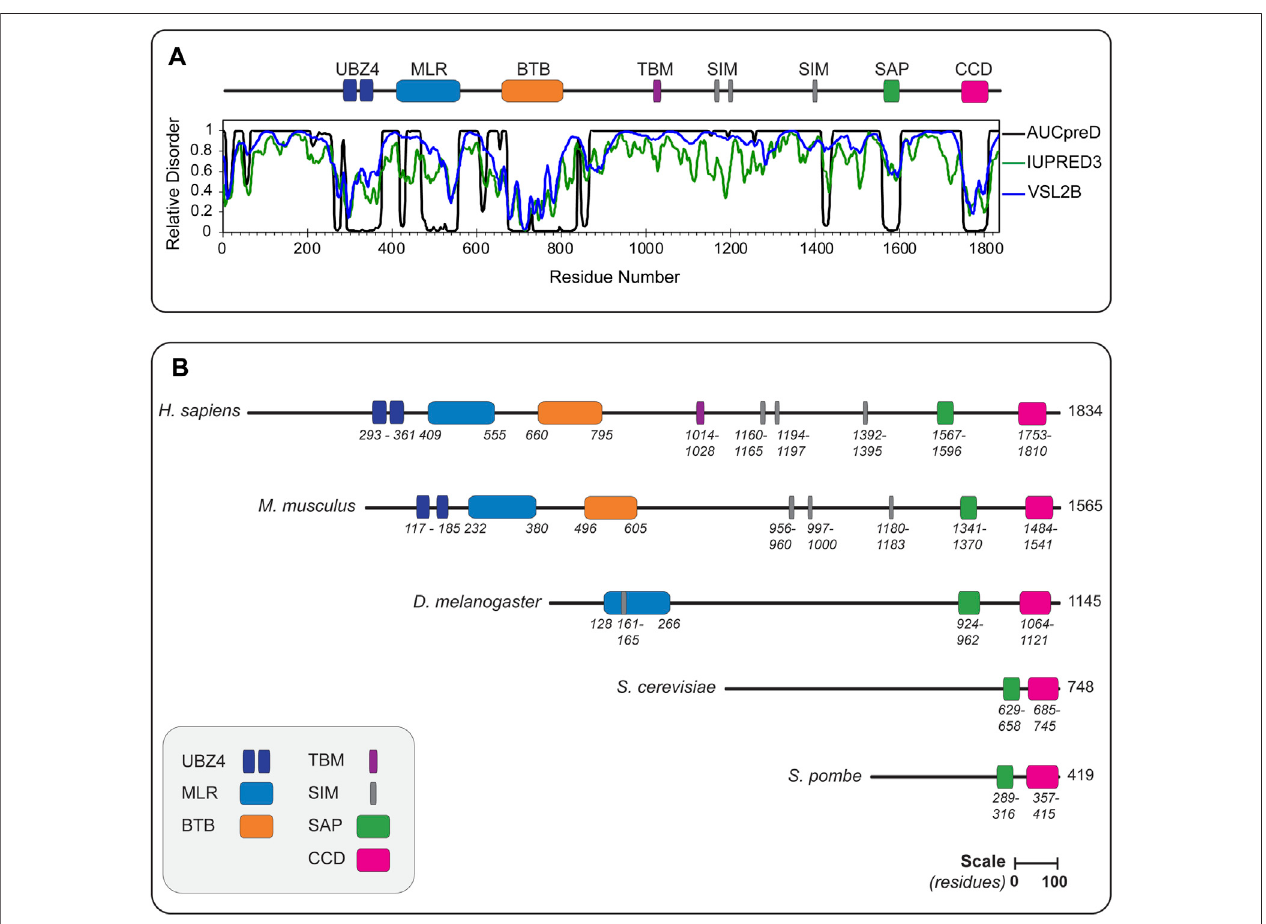
FIGURE 3 | (A) Disorder probability plots for human SLX4 using the AUCpreD (black trace) (Wang et al., 2016), IUPRED3 (green trace) (Erdos et al., 2021) and VSL2B(bluetrace)(Penget al.,2006)predictors.TheseplotsrevealthatSLX4 ispredicted tobe largelydisordered, asindicatedbyadisordertendency score > 0.5. The domainorganizationofhumanSLX4isshownabovethedisorderprobabilityplots. (B) ThedomainorganizationofSLX4proteinsfromdifferenteukaryotes.Domainsare coloredasindicatedinthelegend(lowerleft).Thelengthofeachproteinisindicatedinaminoacids,asarethedomainboundaries.Alltheproteinsareshownonthe same scale (scale bar represents 100 residues). Abbreviations for protein domains: UBZ4, ubiquitin-binding zinc fi nger type 4; MLR, MUS312-MEI9 interaction-like region; BTB, Broad-Complex, Tramtrack and Bric a Brac; TBM, TRF2-binding motif; SIM, SUMO-interacting motif; SAP, SAF-A/B, Acinus and PIAS; CCD, conserved C-terminal domain. Abbreviations for organism names and UniProt identi fi er (in parenthesis): H. sapiens , Homo sapiens (Q8IY92); M. musculus , Mus musculus (Q6P1D7); D. melanogaster , Drosophila melanogaster (Q9VS48); S. cerevisiae , Saccharomyces cerevisiae (Q12098); S. pombe , Schizosaccharomyces pombe